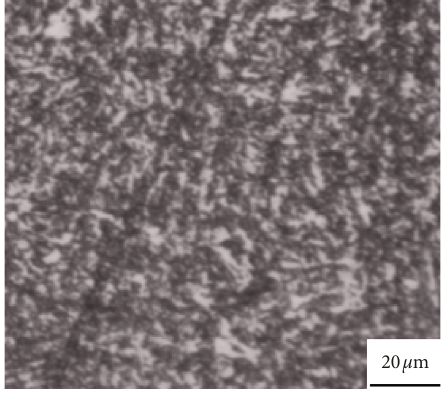
Figure 1: Microstructure of 20# steel. Table 1: Mechanical material